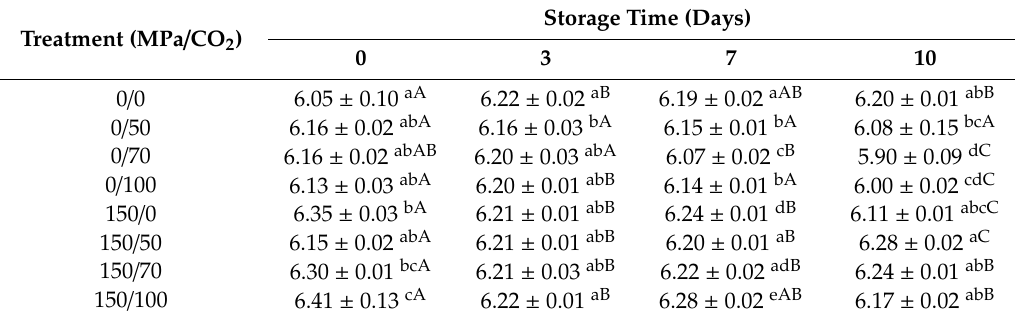
Table 2. E ff ect of treatment and refrigerated storage time on pH of coho salmon